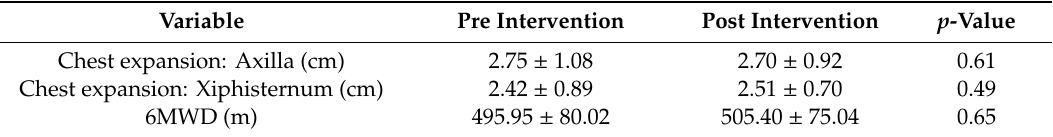
Table 2. Comparison of pre and post intervention chest expansion and 6MWD in the control group: Mean ±